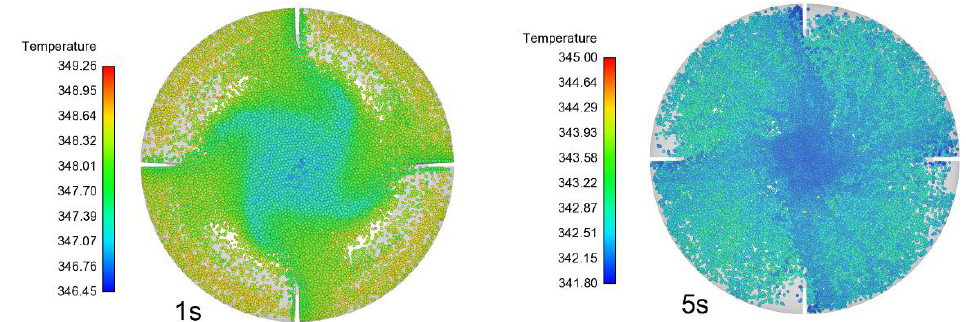
Figure 21. Schematic diagram of temperature and distribution of particles at the bottom on stirred tank with baffles.